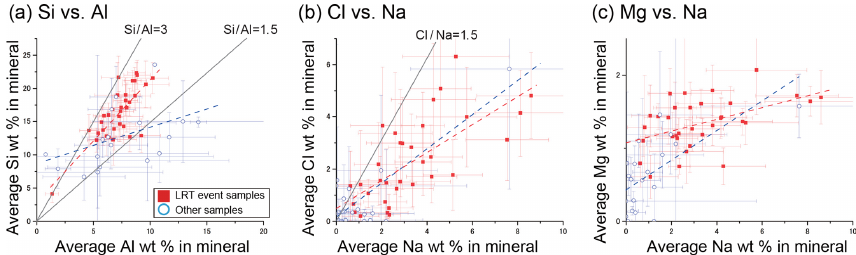
Figure 7. Relations (a) between average Si and Al weight percent in mineral particles, (b) between average Cl and Na weight percent in mineral particles, and (c) between average Mg and Na weight percent in mineral particles. Red squares indicate sample averaged values for LRT period samples. Open blue circles indicate sample average values for other (non-LRT period) samples. The sample from 09:00 on 6 February had only one mineral particle and is not shown in the plots because it has a large Al fraction and no Na (0, 30, and 1wt% for Na, Al, and Si, respectively). Coefficients of R 2 of determination for (a) , (b) , and (c) were 0.60, 0.47, and 0.24 for the LRT period samples and 0.18, 0.66, and 0.40 for other samples, respectively. Trend lines are shown in red and broken blue lines for LRT period and other samples, respectively. The correlation between Si and Al for other samples (a) is relatively low because of possible contributions from two sources (LRT and local dusts). Error bars indicate the 95% confidence